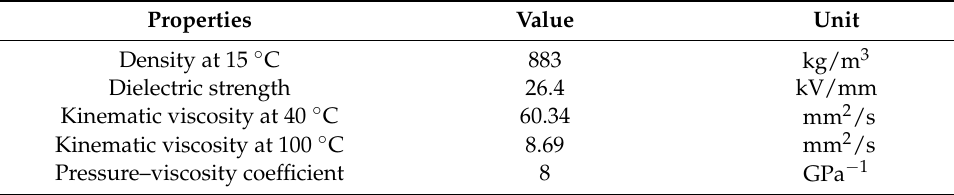
Table 3. The physical properties of the WW1362